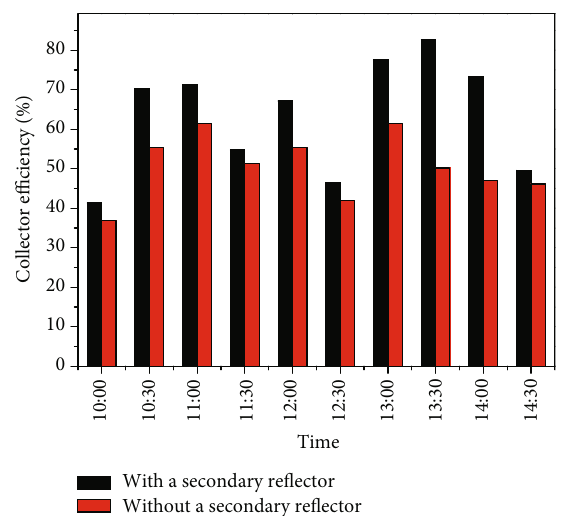
Figure 7: Variation of collector e ffi ciency with time.